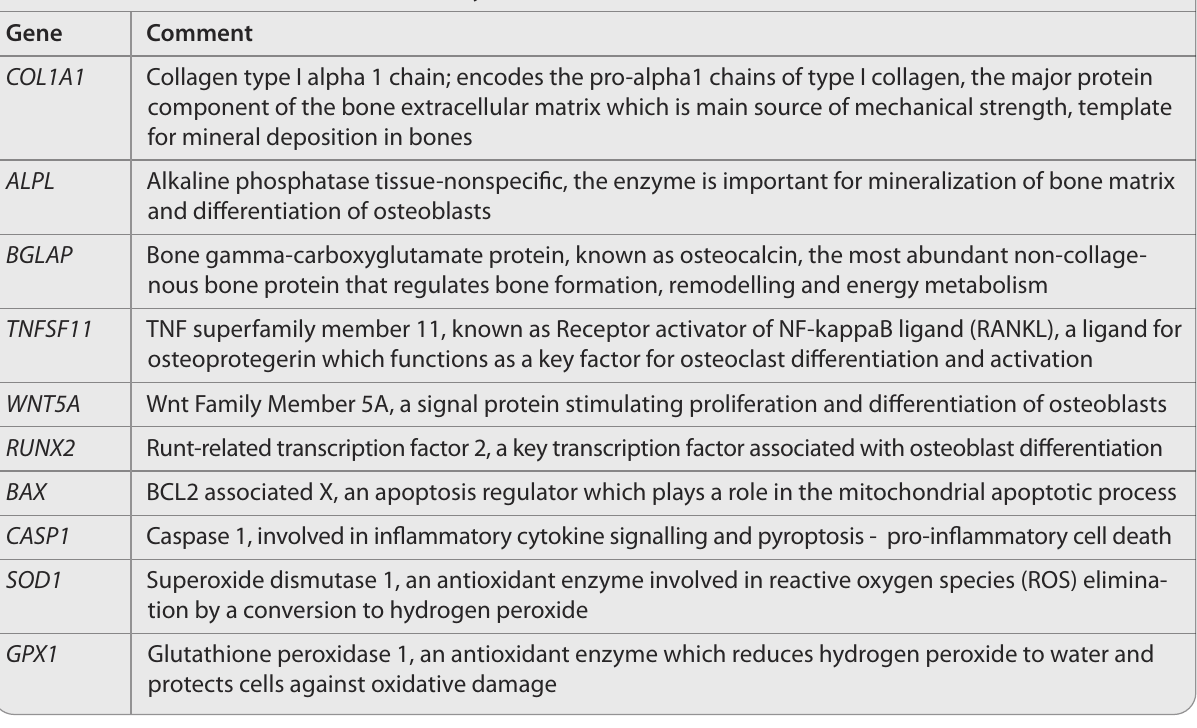
Table 1. Genes included in the current